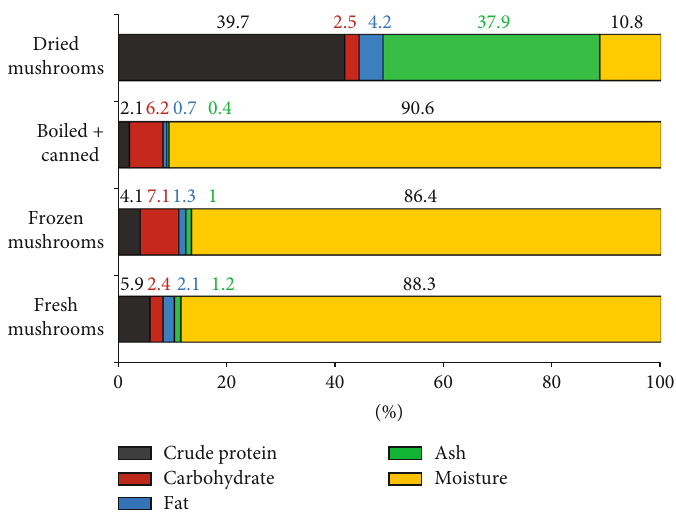
Figure 3: Composition of the fruiting bodies depending on the method of preservation in comparison with the fresh fruiting bodies (developed in: Aydin et al.